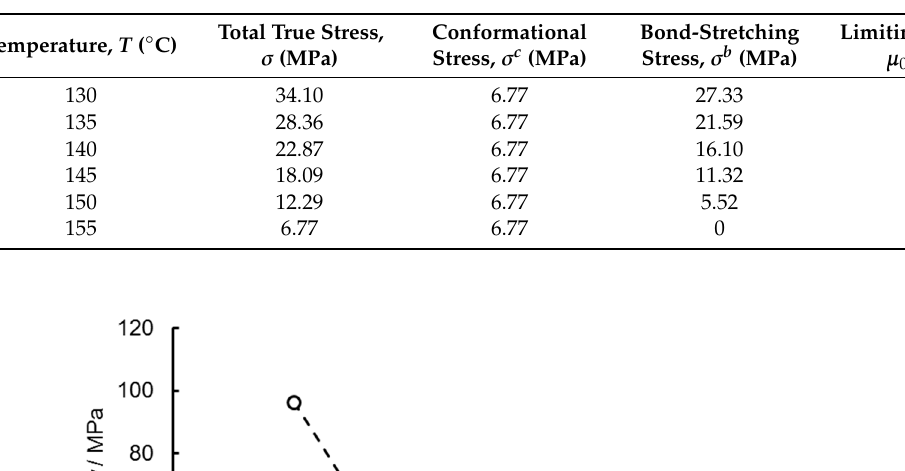
Table 2. Bond-stretching stresses and limiting viscosities for di ff erent temperatures at strain of 0.2 at 1 s − 1, for EB deformation.